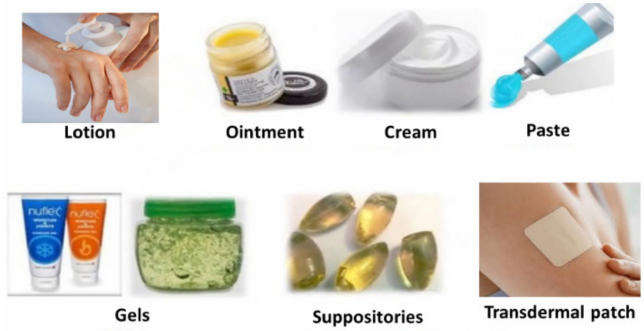
Figure 7. Semisolid dosage